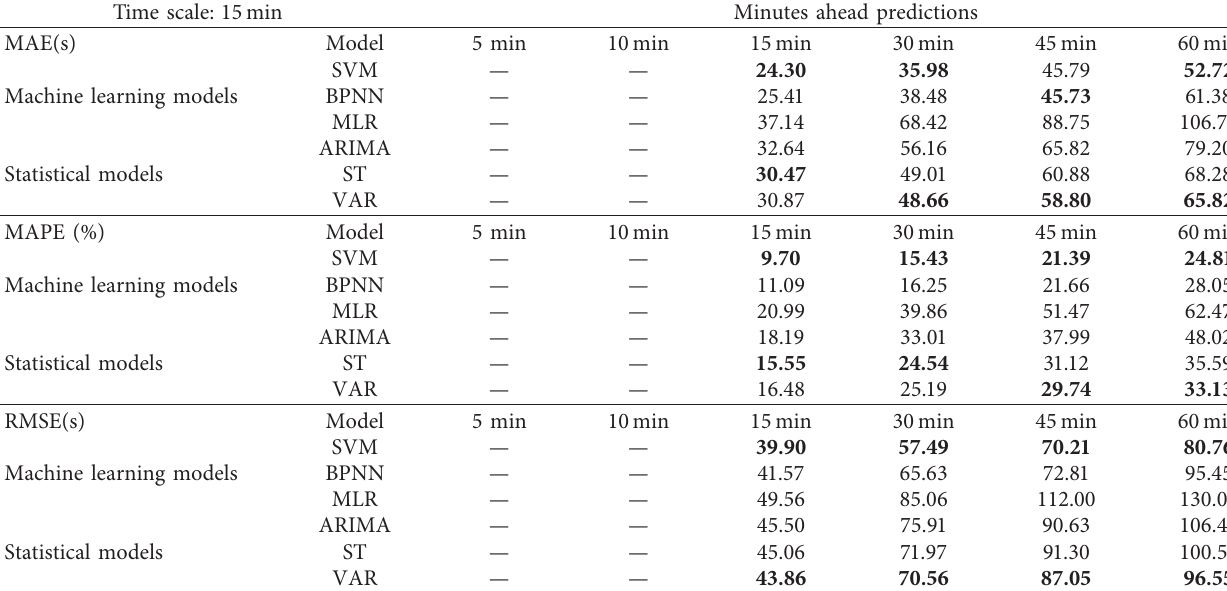
Table 3: MAE, MAPE, and RMSE of six models for different minutes ahead predictions with 15-minute as aggregating level. Time scale: 15min